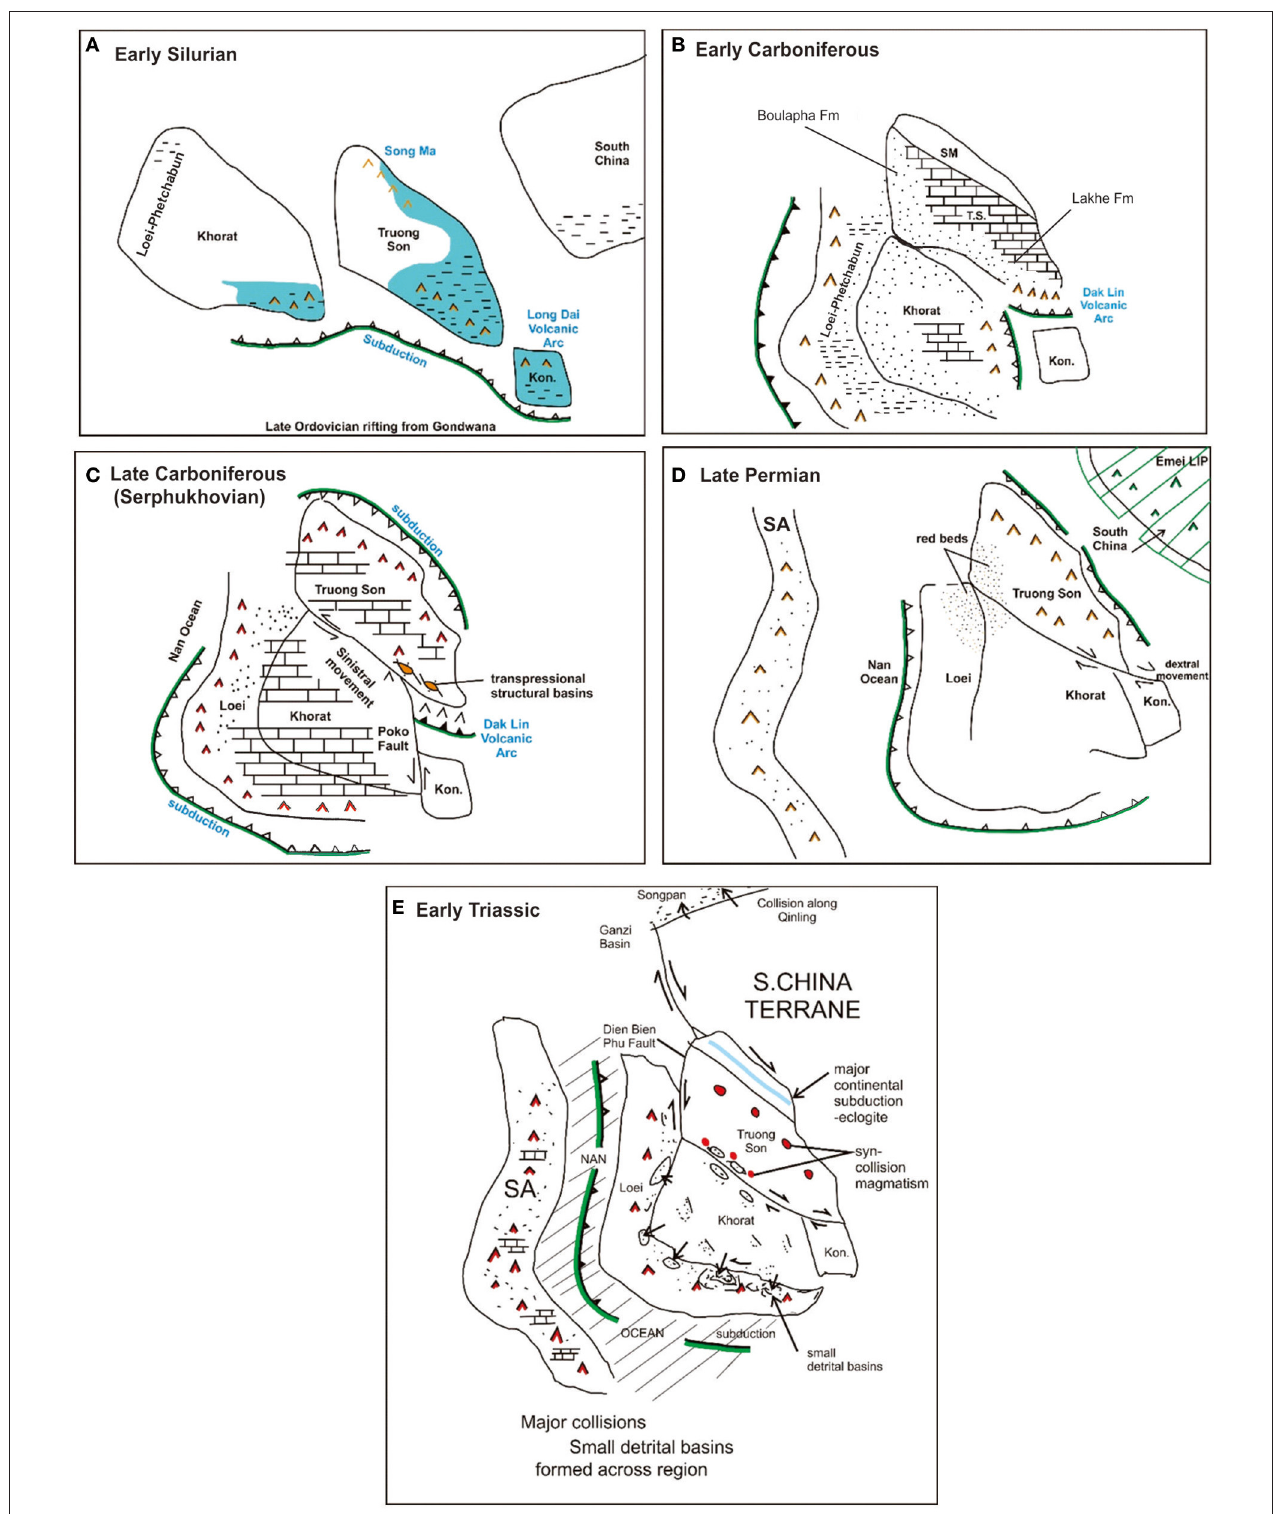
FIGURE 15 | Speculative palaeogeographic sketches showing suggested rifting, convergence, and fusion of the Truong Son, Loei-Phetchabun, and Kontum terranes. Kon, Kontum Terrane; LDV, Long Dai Volcanic Arc (late Ordovician to Silurian); SA, Sukhothai Terrane (Permo-Triassic volcanic arc—see Figure 1 ), and